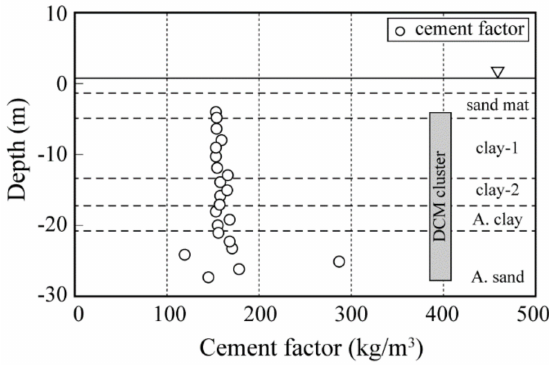
Figure 15. Distribution of binder factor along